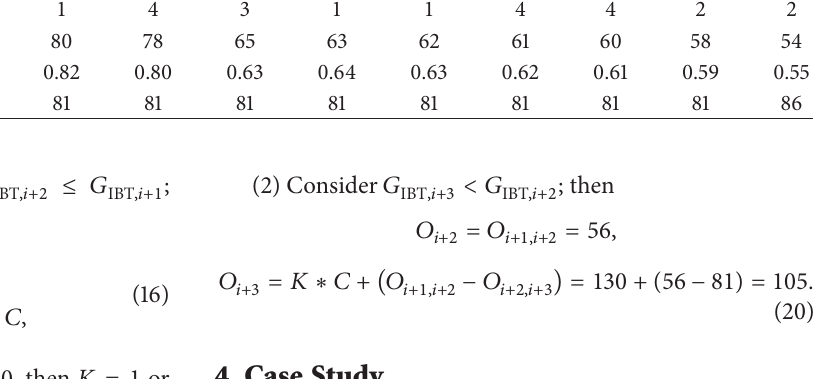
Table 5: Optimized results for 𝐿 𝑖+1,𝑖+2 on Kietzke Lane ( 𝐺